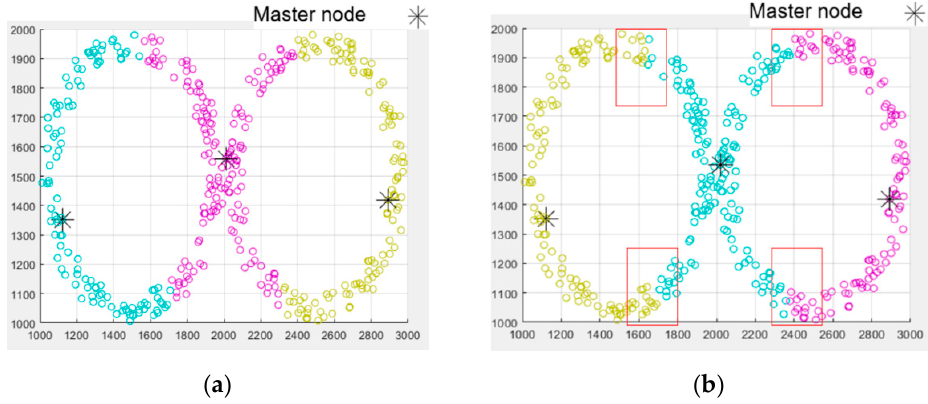
Figure 15. ( a ). K-means clustering result 1 (K = 3 with 5 iterations). ( b ) Result 2. Axes are in units of meters.